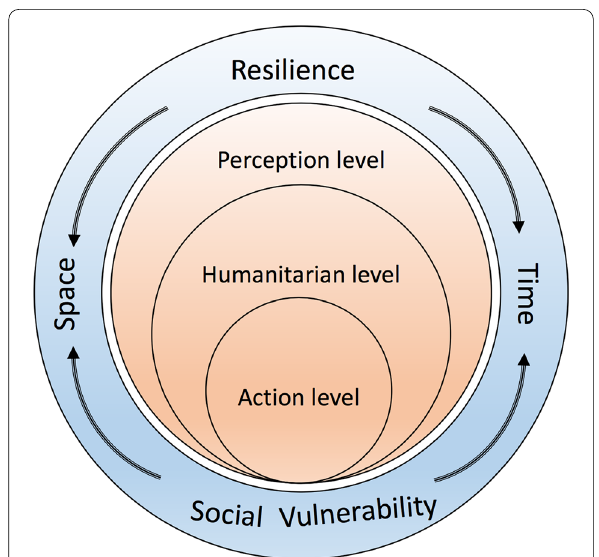
Fig. 1 Three levels of situational